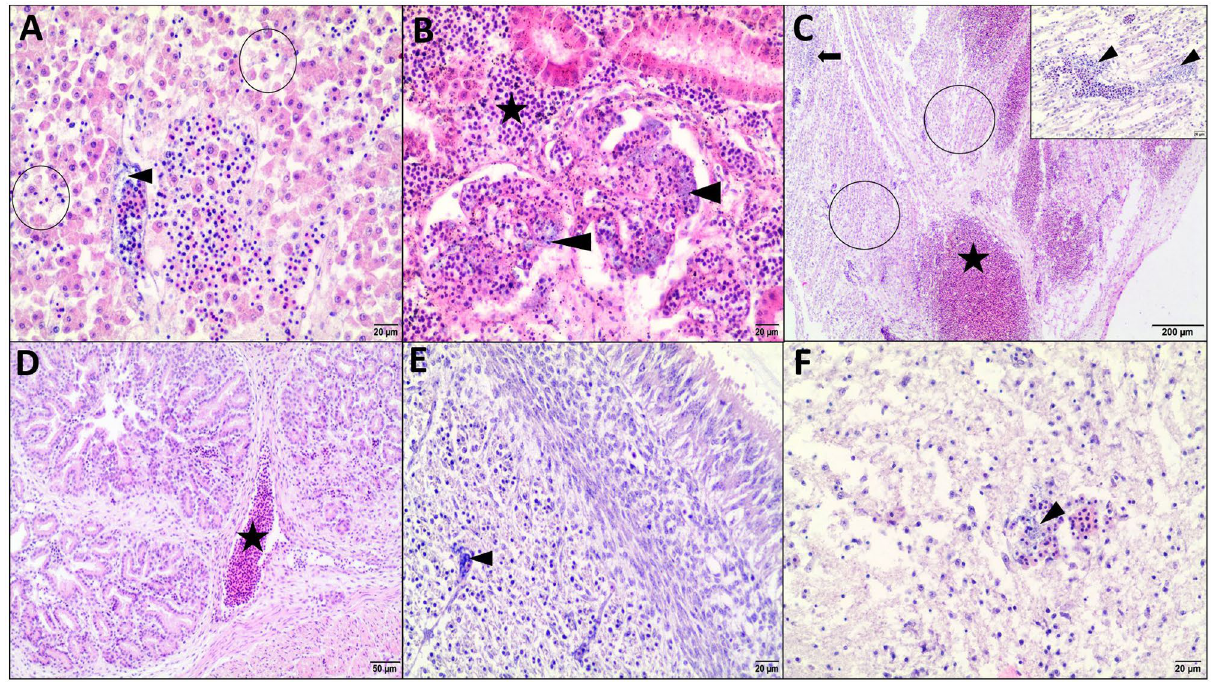
Figure 4. Histopathological lesions in chicken embryos that died (on 13 di, 2 dpi) following infection with clinical Enterococcus cecorum strains. HE stain. (A) Liver: severe congestion, degenerated and necrotic hepatocytes (circles), loosely arranged hepatic trabeculae, bacterial colonies in blood vessels indicated by arrowhead. Bar: 20 µm. (B) Kidneys: severe congestion, hemorrhages (*), capillary blood vessels of glomeruli with bacteria (arrowheads), degenerated and necrotic epithelial cells of renal tubules. Bar: 20 µm. (C) Heart: multifocal necrotic areas (circles), massive hemorrhages (*) and severe congestion. Bar: 200 µm; Insert: blood vessels with bacterial aggregates, necrotic cardiomyocytes. Bar: 20 µm. (D) Proventriculus. severe congestion (*) and edema of the stroma. Bar: 50 µm. (E) Gizzard: diffuse necrotic muscle fibers. Arrowhead indicated blood vessels with bacteria in the muscle layer. Bar: 20 µm. (F) Brain: bacterial aggregates (arrowhead) in the blood capillary, pyknosis of glial nuclei and cerebral malacia. Bar: 20 moderate congestion. Bacteria were not found in blood vessels (Fig. 5A–F). Embryos infected with commensal strains showed a mild degree of histopathological lesions (mainly congestion, hepatocyte degeneration, and mild infiltration consisting of heterophils and mononuclear cells) (Fig. 5G–H). Figure 5I shows a representative image of the control group. Reisolation of E. cecorum after Infection. Pure cultures of E. cecorum were reisolated from inoculated embryos, but none of the control group. E. cecorum was reisolated from all organs (yolk sac, heart, gizzard) of dead embryos (on 13 di, 2 dpi) and from all organs except gizzard (16.7%) of surviving embryos (on 18 di, 7 dpi). The number of reisolated E. cecorum from the whole heart (cfu/heart) did not significantly differ between clinical and commensal strains in dead embryos and surviving embryos (Table 4) (it was higher in a non-signif- icant manner in commensals). Bacterial loads in the whole heart of embryos that died (on 2 dpi) after inocula- tion with approx. 3.4 × 10 7 cfu/egg of E. cecorum reached approx. 3.73 × 10 7 cfu for clinical strains and approx. 10.5 × 10 7 cfu for commensal strains. The number of reisolated E. cecorum from the whole heart of surviving embryos (on 7 dpi) was markedly lower and reached approx. 6.57 × 10 2 cfu for clinical strains and 18.3 × 10 2 cfu for commensal strains. The comparison of the results of bacterial load (cfu/g) between the organs of dead and surviving embryos is shown in Table 5. Reisolation (cfu/g) was significantly higher in all organs of dead embryos compared with that in surviving embryos for clinical ( p < 0.001) and commensal ( p = 0.029) strains. The difference in bacterial load (cfu/g) between the organs of dead embryos was significant only for commensal E. cecorum strains ( p = 0.039) (Supplementary Table 4). Reisolation of E. cecorum from surviving embryos was significantly higher in the yolk sac than in the heart ( p < 0.001) or gizzard ( p = 0.015) only for clinical strains (Supplementary Table 5). Bacte- rial loads in organs did not differ significantly between clinical and commensal strains in embryos that died (on 13 days, 2 dpi) (Supplementary Table 4) and in those that survived infection (on 18 di, 7 dpi) (Supplementary Table 5). Body mass. Results of body mass were presented without the yolk sac contents (yolk-free embryo weight). The inoculating dose did not influence the body mass of embryos. Body mass was significantly lower ( p = 0.006) in embryos infected with clinical strains (21.61 g; 95% CI: 21.39 g, 21.82 g) compared with those infected with